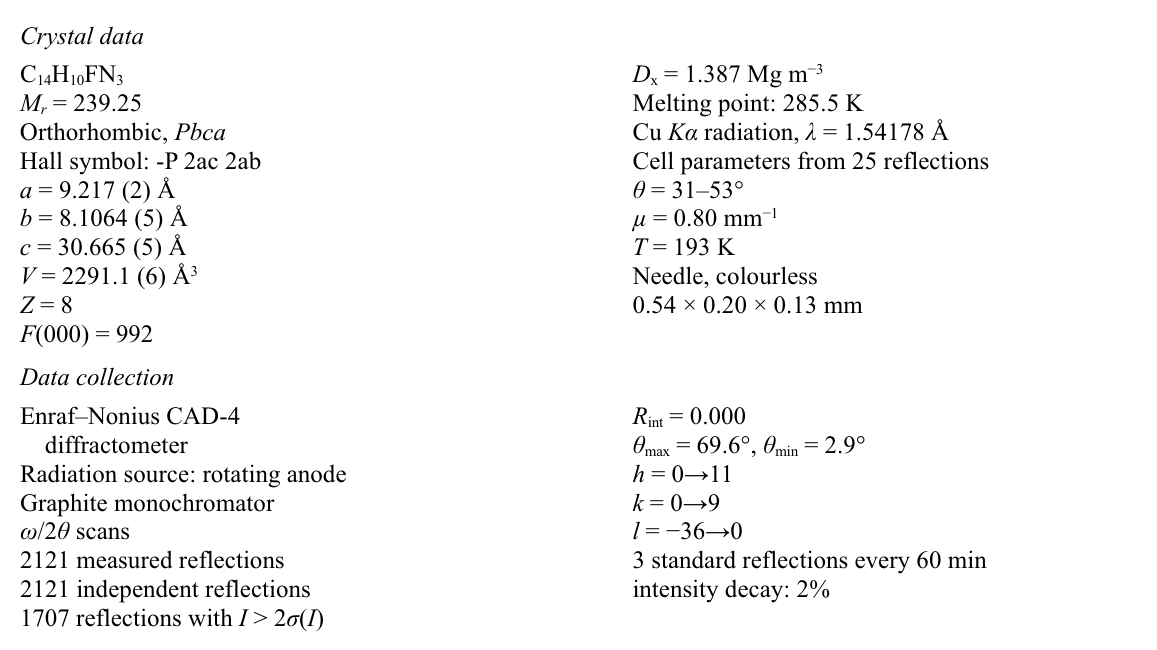
Figure 2 Part of the crystal packing of compound I . The hydrogen bonds are represented by dashed lines. View along b axis. 4-[5-(4-Fluorophenyl)-1 H